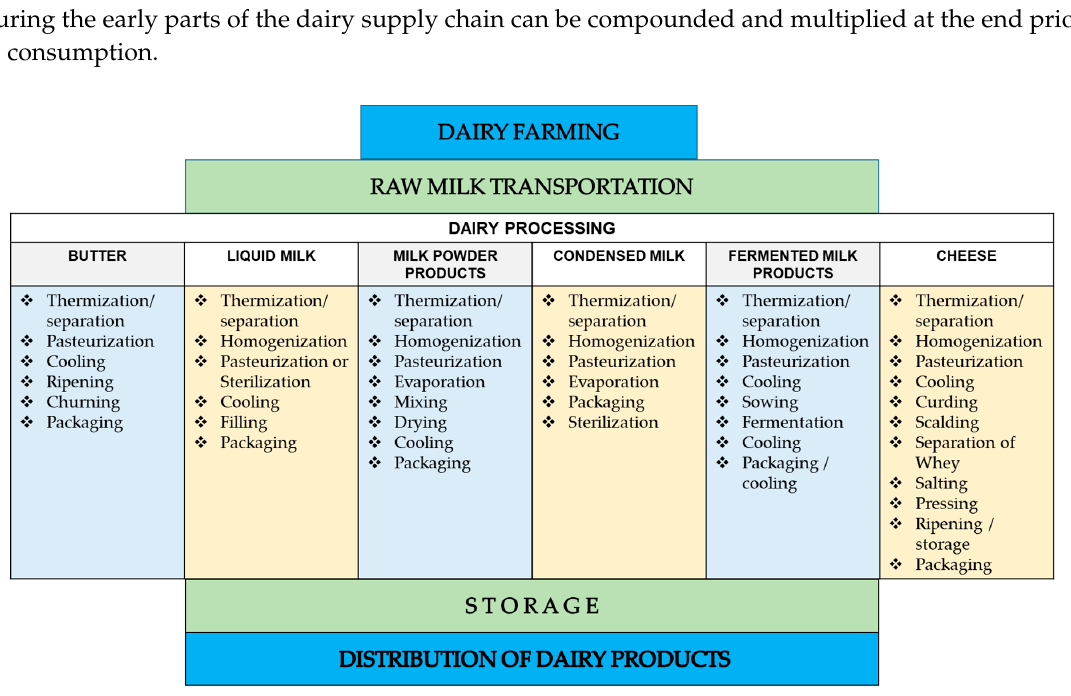
Figure 1. Scheme of the dairy supply chain from raw milk to the distribution of dairy products with unit operations